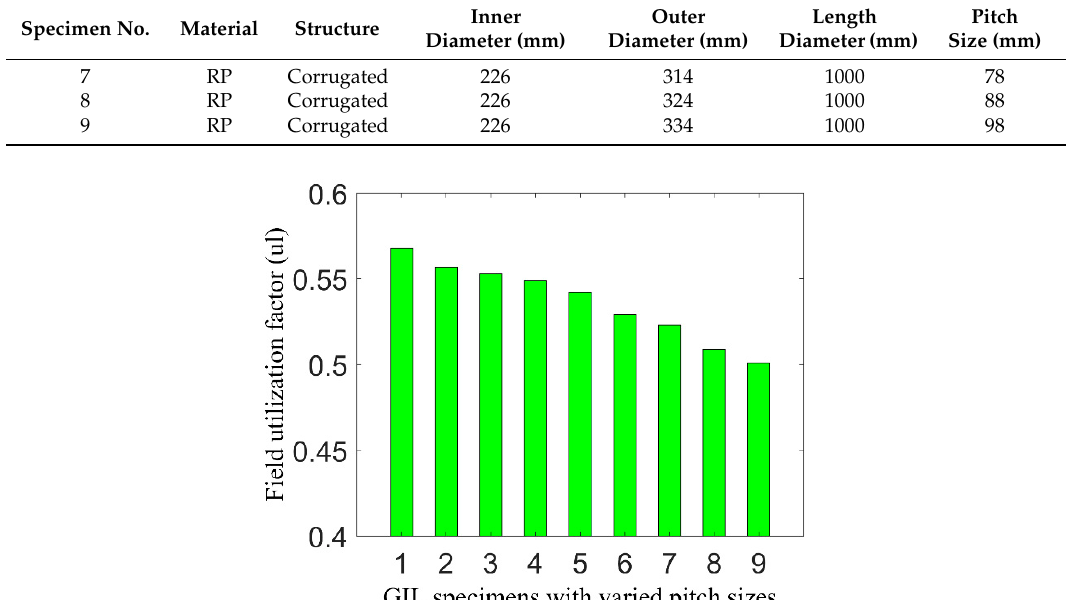
( b ) Figure 10. ( a ) Cross-sectional view and dimensional specifications of designed sphere gap discharge chamber; ( b ) Enclosed sphere gap discharge chamber fabricated as per design specifications of Figure 10a.